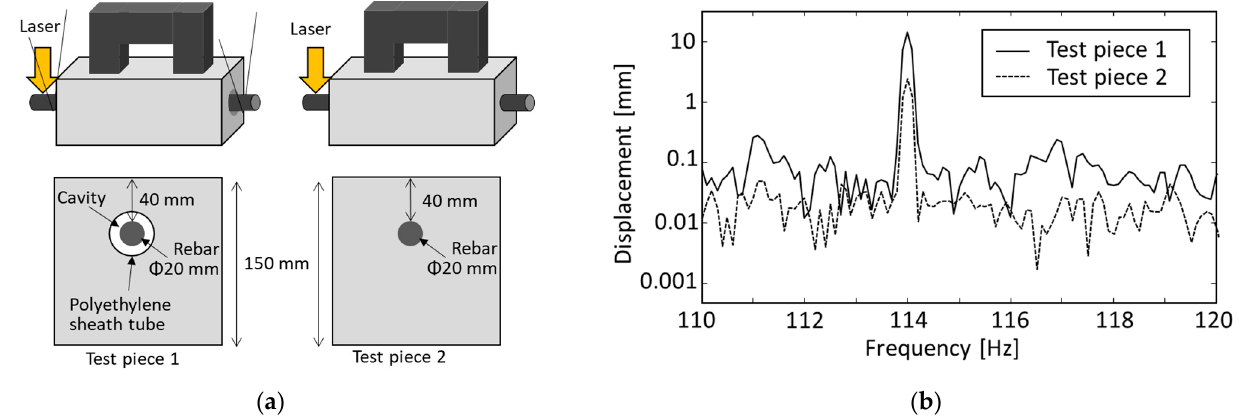
Figure 5. Measurement of rebar vibration displacement in concrete: ( a ) Experimental setup; ( b ) Displacement spectrum measured at the end of the rebar.